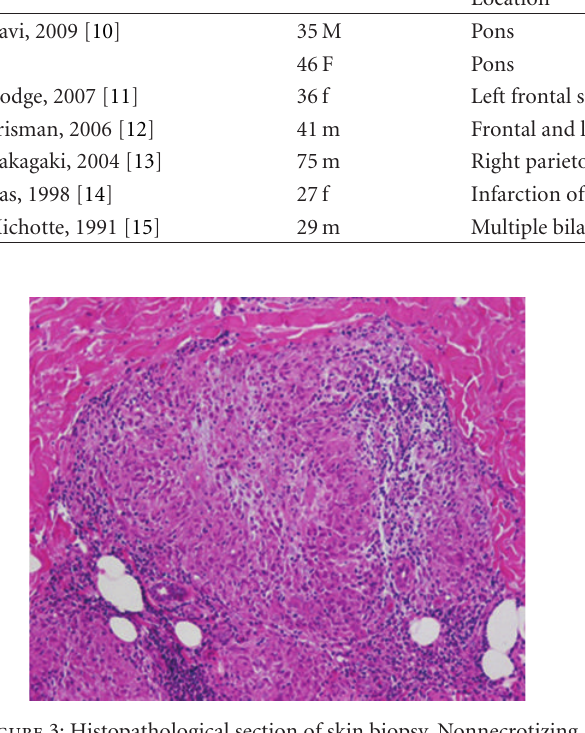
Figure 3: Histopathological section of skin biopsy. Nonnecrotizing granuloma with several multinucleated giant cells and epitheliod histiocytes can be seen. Hematoxylin-eosin ×